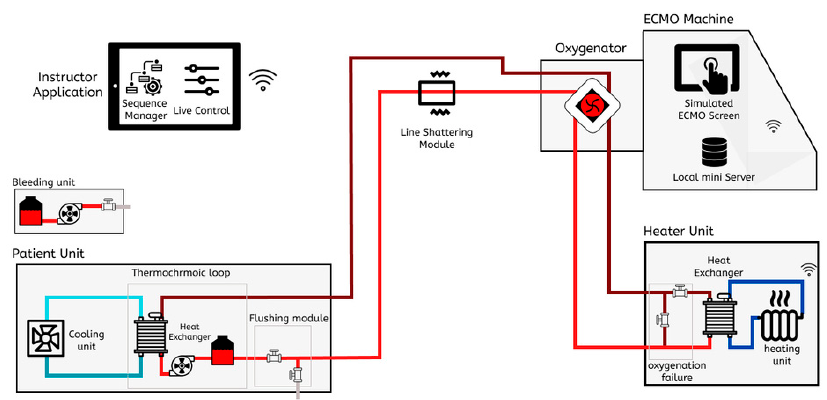
Figure 1. Overview of the ECMO simulation system.